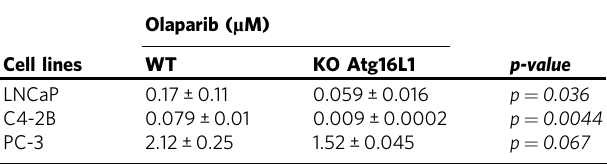
Table 1 IC 50 values for olaparib between PC wild-type and KO Atg16L1 cell